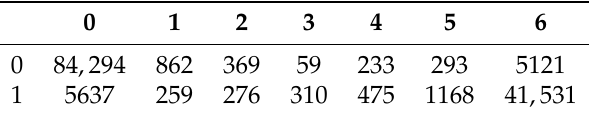
Table 1. A joint site frequency spectrum of Drosophila short intronic sites with M 0 = 1 and M 1 = 6. The left-most column and the upper row of the table represent the possible allelic states of sites for the sample M 0 and M 1 , respectively. The interior entries of the table are the counts of sites with a specific allelic state with respect to Allele 1.